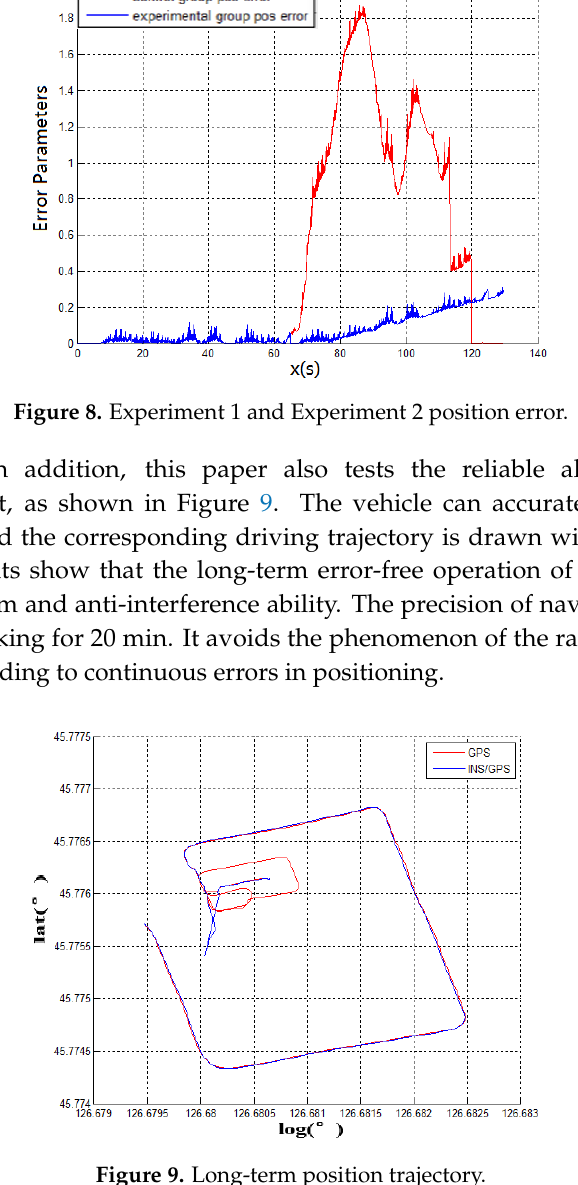
Figure 9. Long-term position